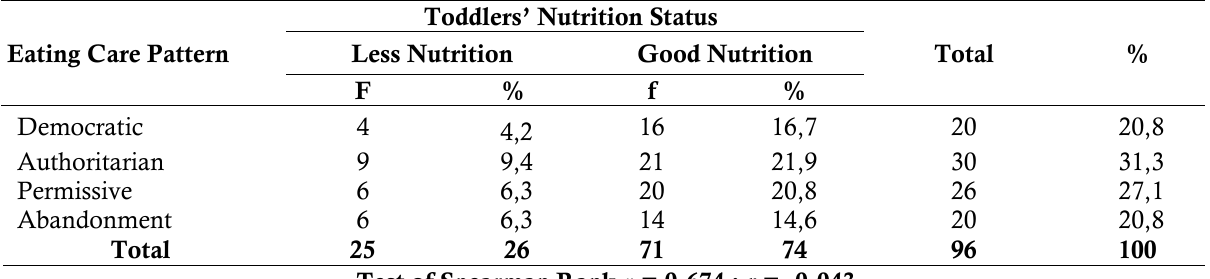
Table 3. Analysis of the relationship parental eating patterns and nutritional status of toddlers